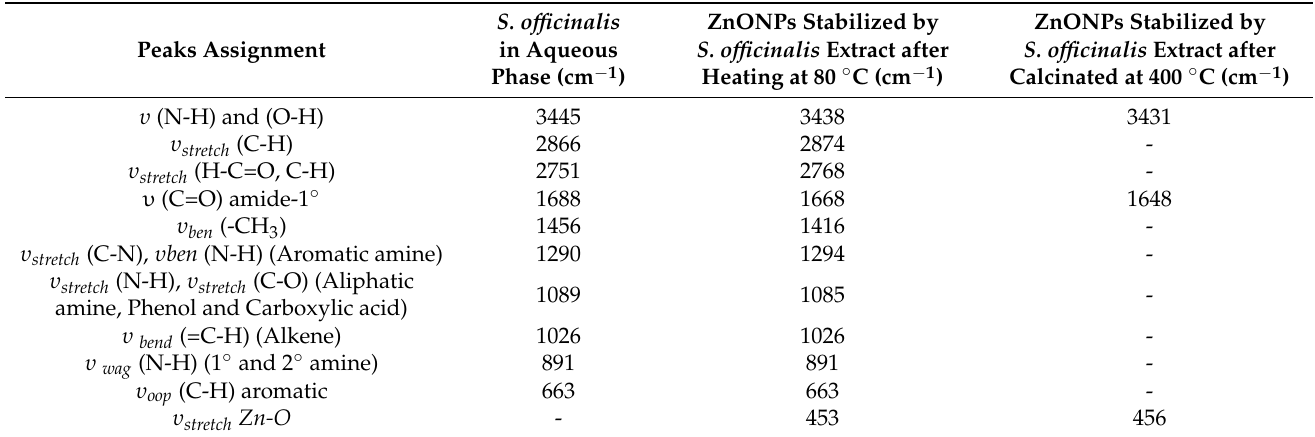
Table 1. Spectral positions of FTIR peaks and corresponding mode assignments of S. officinalis aqueous leaf extract and stabilization of ZnONPs by S. officinalis